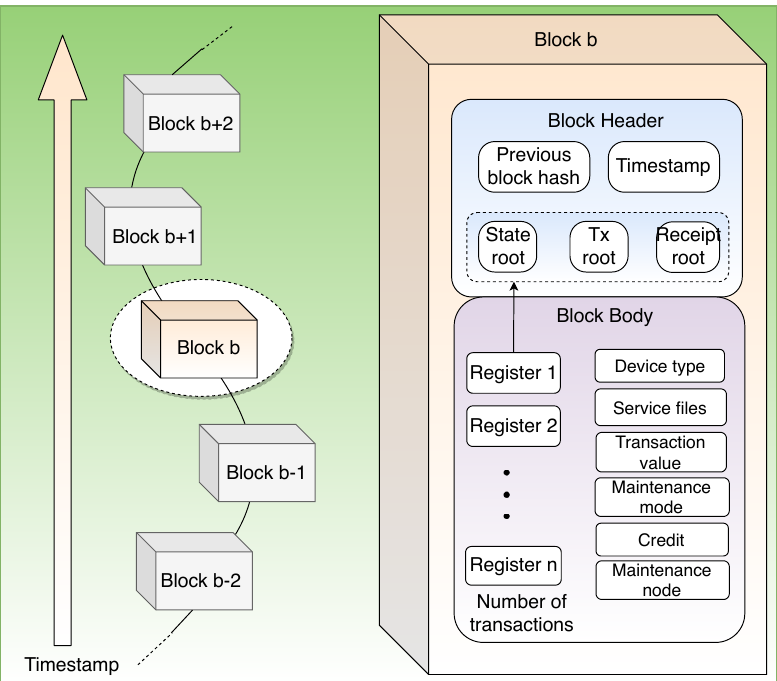
Figure 12. Block structure for secure equipment maintenance.